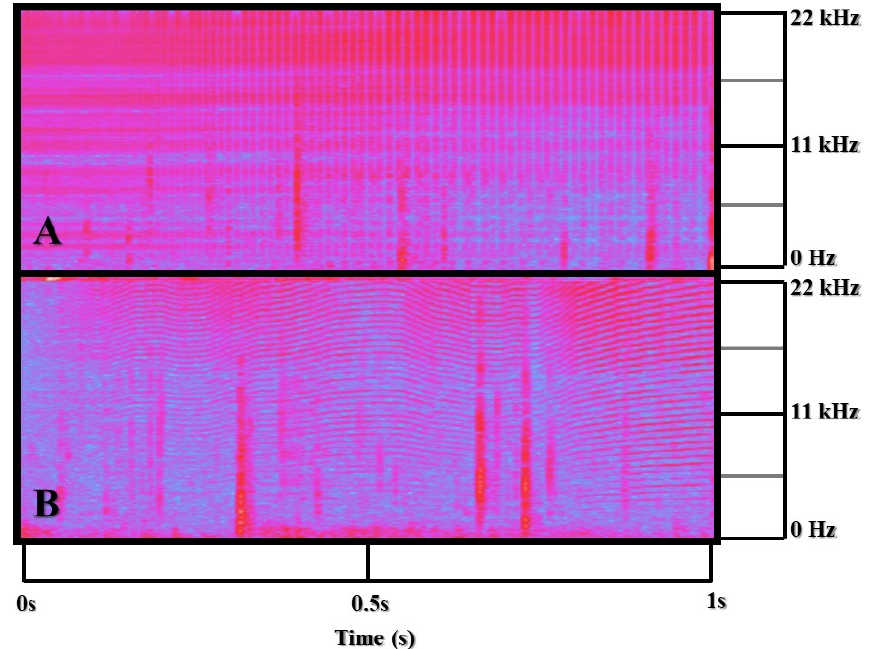
Figure 5. Echolocation bout and burst pulse spectrograms (Hz). ( A ) Spectrogram of an echolocation click train. ( B ) Spectrogram of a burst pulse response with clear harmonic features. The vertical bands shown in red are snapping shrimp present in the natural soundscape.